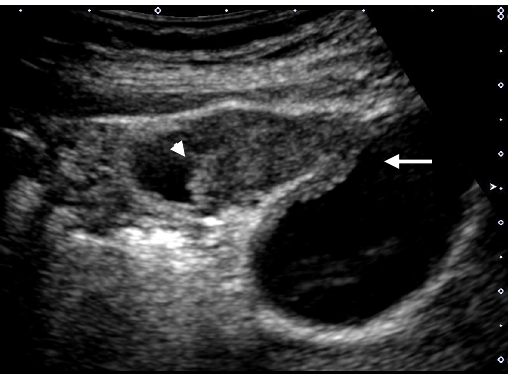
Figure 14. GBC concomitant with segmental ADM. A high-frequency transducer delineated a hypoechoic sessile GBC (arrowhead) in the fundus distal to the annular stricture (arrow).